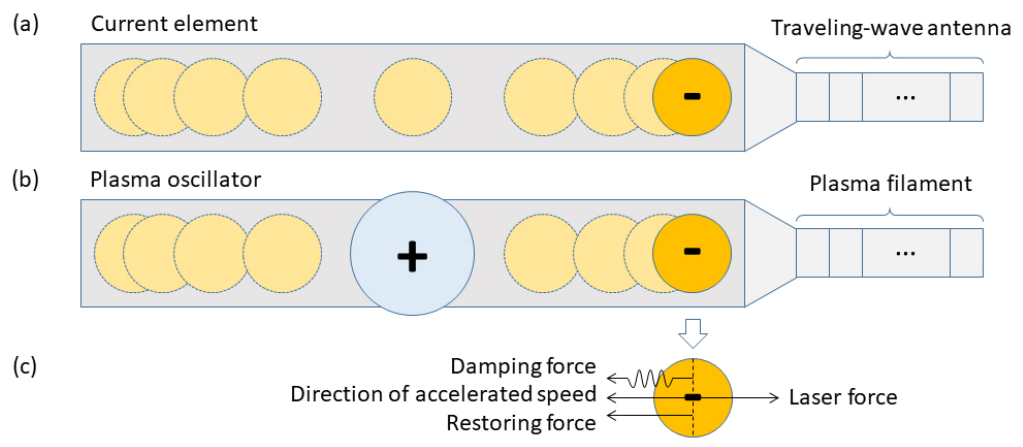
Figure 1: Microscopic view between the traveling-wave antenna and the plasma filament. (a) The schematic of a traveling-wave antenna with periodic current el- ements, inside which the electron (-) gains accelerated velocities at both